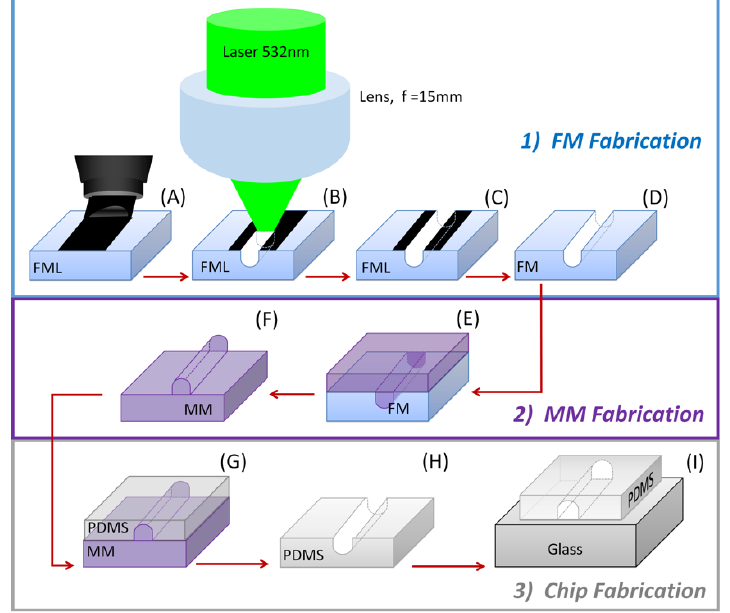
Figure 1. Fabrication method to obtain poly(dimethyl siloxane) (PDMS) devices with three main fabrication steps, ( 1 ) female mold (FM) fabrication, ( 2 ) male mold (MM) obtaining, and ( 3 ) chip assembling. ( A ) Layer film made on a face of polystyrene (PS) spectrophotometer cuvette by black sharpie marker (FML), ( B ) laser writing of the microchip features into the FML, ( C and D ) FM obtained by cleaning the ablated cuvette surface and cutting the imprinted side, ( E and F ) resin layer casting on the FM and peeled off to obtain a MM, ( G and H ) PDMS were cast on the MM and peeled off from it to get a polymeric chip layer, and ( I ) the final microchip is obtained by assembling the PDMS onto a glass slide.